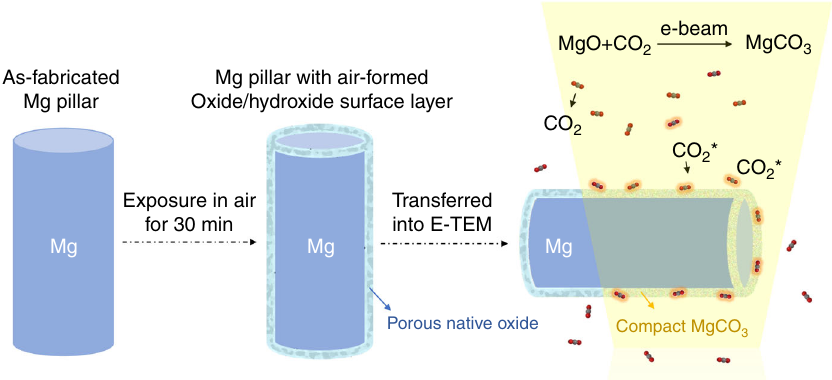
Fig. 1 Schematic diagram showing how to transform the native surface to MgCO 3 . A Mg micropillar with electron beam transparent size is fabricated by focused ion beam (left), and then exposures in air for 30 min to form a native oxide fi lm (middle). After being transferred into the E-TEM, the air-formed surface layer is expected to react with the e-beam excited CO 2 * , and produce a compact MgCO 3 protective layer on the pillar ’ s surface without any extra